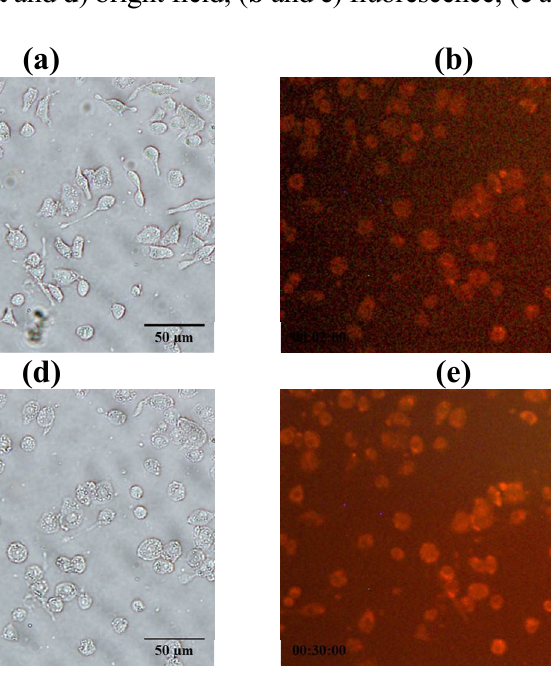
Figure 12. Phagocytosis of NR8383 cells incubated with reconstituted LEV-proliposome formulation No.1 stained with Lumidot ® 640 at ( a – c ) 2 min; ( d – f ) 30 min in different mode; ( a and d ) bright field; ( b and e ) fluorescence; ( c and f ) overlay (bar = 50